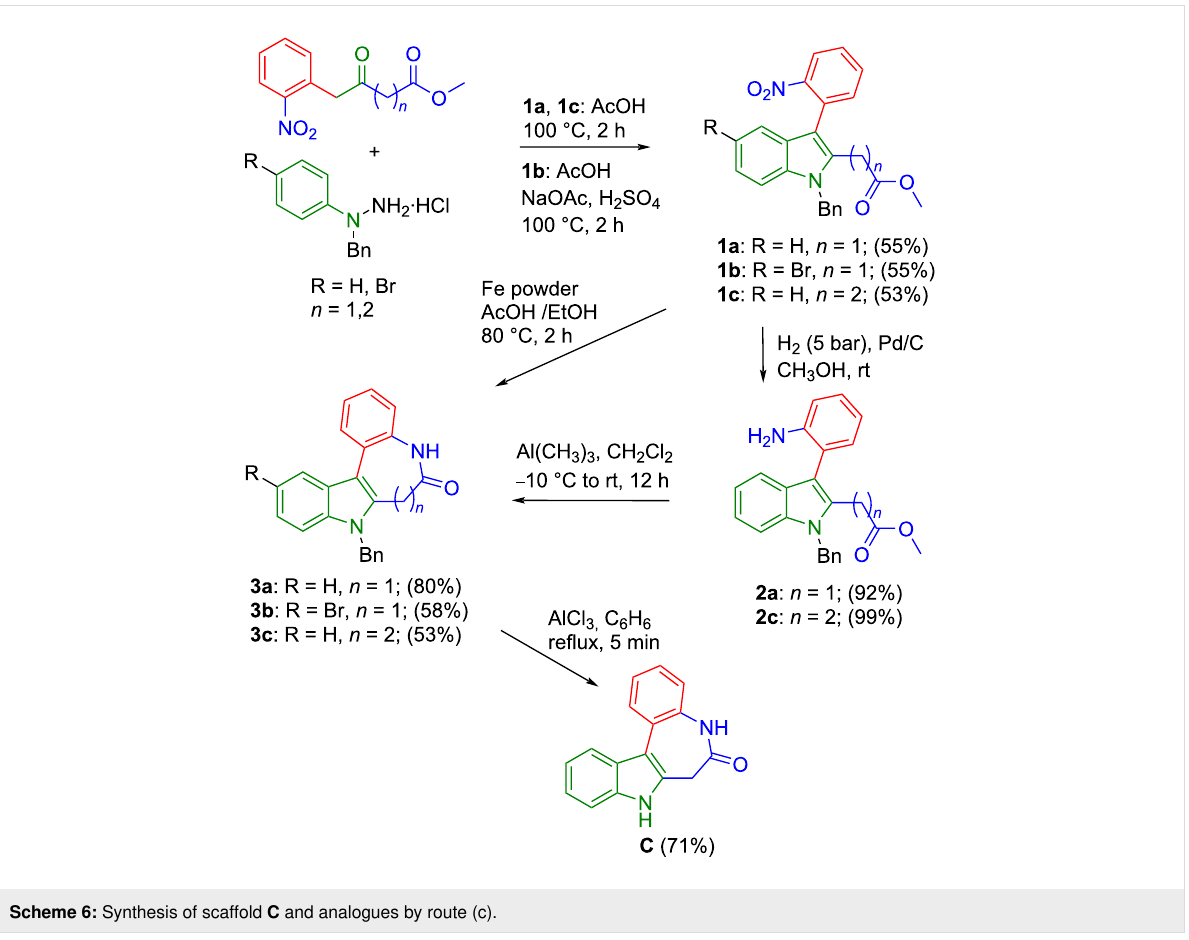
Scheme 6: Synthesis of scaffold C and analogues by route (c).